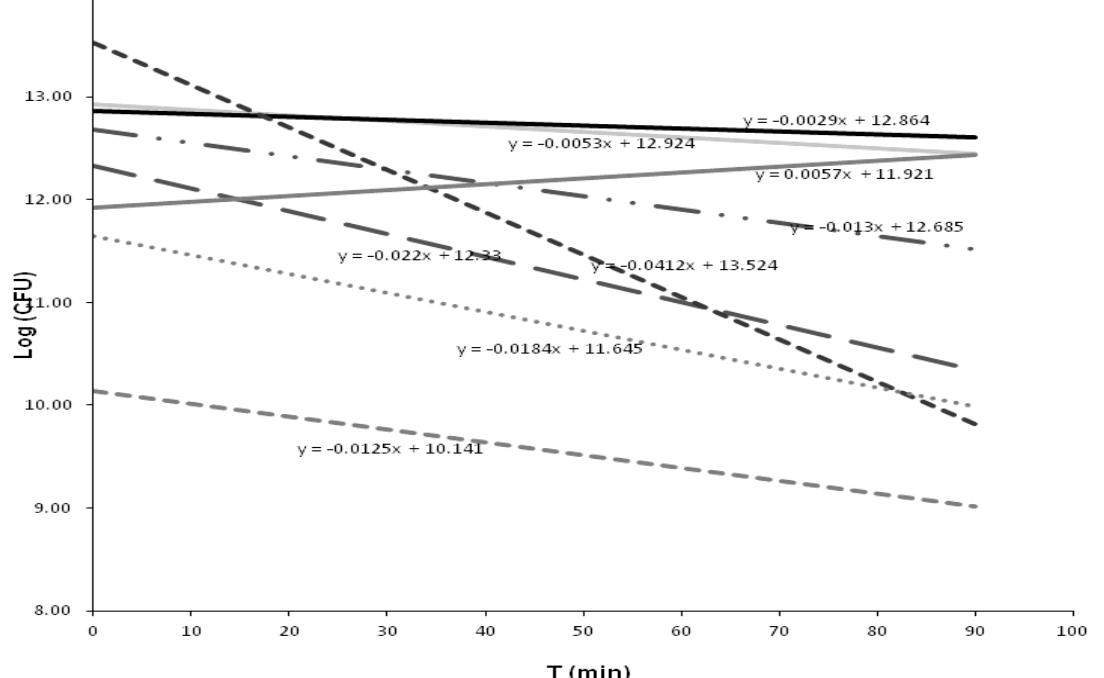
Figure 4. Response of the bacterial strains to the treatment, as represented by the trend line and slope value. K. cryocrescens a ( y = −0.012 x + 10.14). K. cryocrescens b ( y = −0.005 x + 12.92). K. cryocrescens c ( y = −0.018 x + 11.64). K. intermedia ( y = −0.002 x + 12.86). C. freundii a (y = −0.013 x + 12.68). C. freundii b ( y = −0.0412 x + 13.524). Bacillus sp. FRC_Y9-2 ( y = −0.022 x + 12.33). Enterobacter sp. MS5 ( y = 0.0057 x +